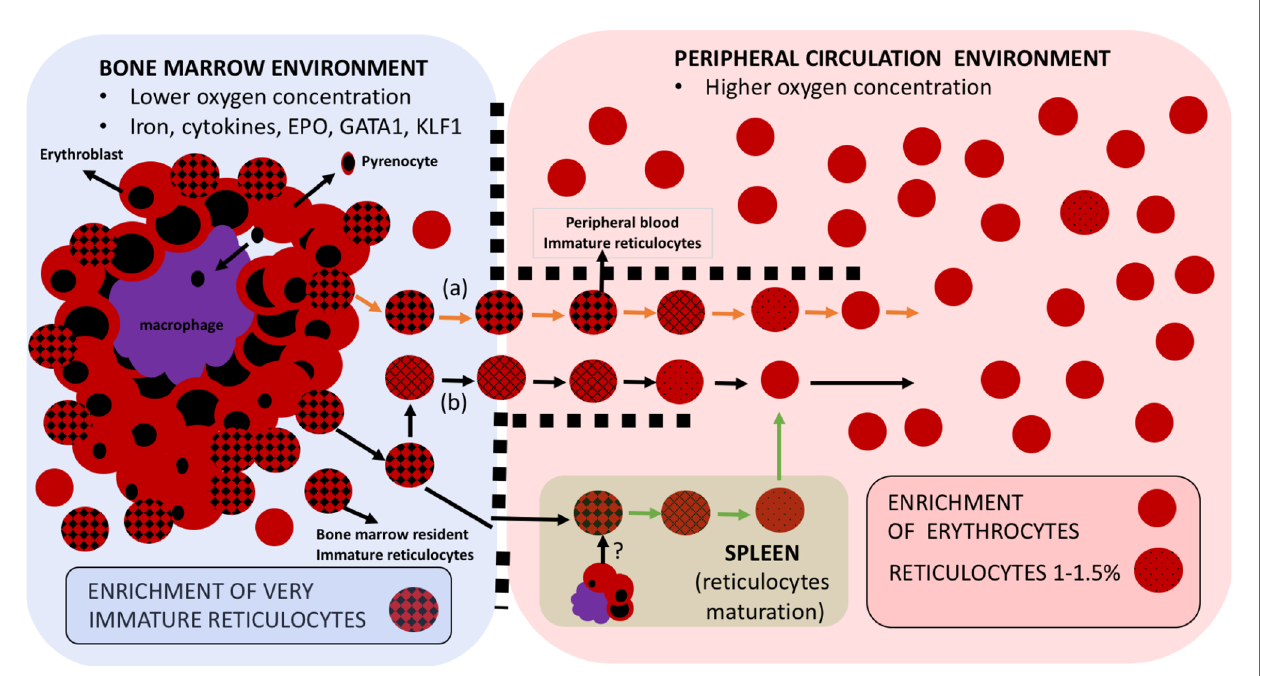
FIGURE 1 | Erythroid cell maturation occurs in different compartments. Reticulocytes emerge in the hypoxic bone marrow compartment upon their predecessor cell in the erythroid lineage, the orthochromatic erythroblasts, expelling its nucleus, in the form of a pyrenocyte, which will be thereafter engulfed by the key scaffold cell of the erythroblastic islands, the central macrophage. These macrophages also play an important role in secreting cytokines that will contribute to the maturation of the whole erythroid lineage from erythroid committed stem cells to CFU/BFU and all the way to reticulocytes. Some recently-enucleated reticulocytes may leave the bone marrow to start maturation in peripheral blood (A) , But mostly they start maturing within the bone marrow compartment (B) to ultimately progress to fully mature RBCs in the peripheral blood compartment with higher oxygen concentration. Immature reticulocytes, sometimes referred to as CD71 high reticulocytes are thus preferentially enriched in the bone marrow but can also be found in peripheral circulation. The spleen represents a hematopoietic organ with potential for erythropoiesis under stress circumstances and where reticulocyte maturation is postulated to